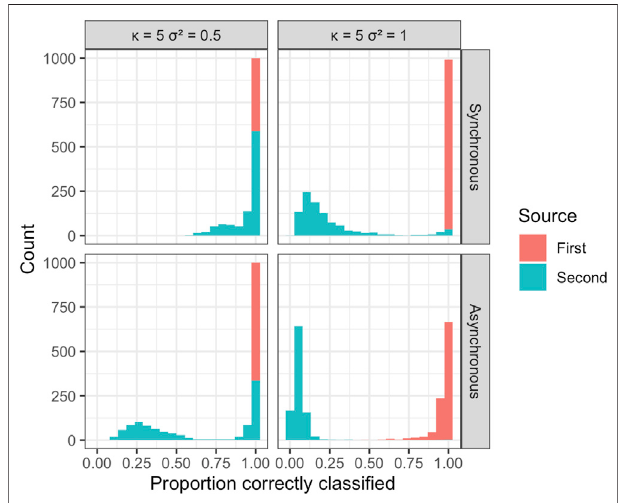
FIGURE6| Resultsfromasimulationexperimentwith n (cid:1) 250; κ (cid:1) 5,two levels of error variance ( σ 2 ), and temporally synchronous or asynchronous epidemics. The histogram summarizes the mean proportion of disease correctly assigned to the true source over 1,000